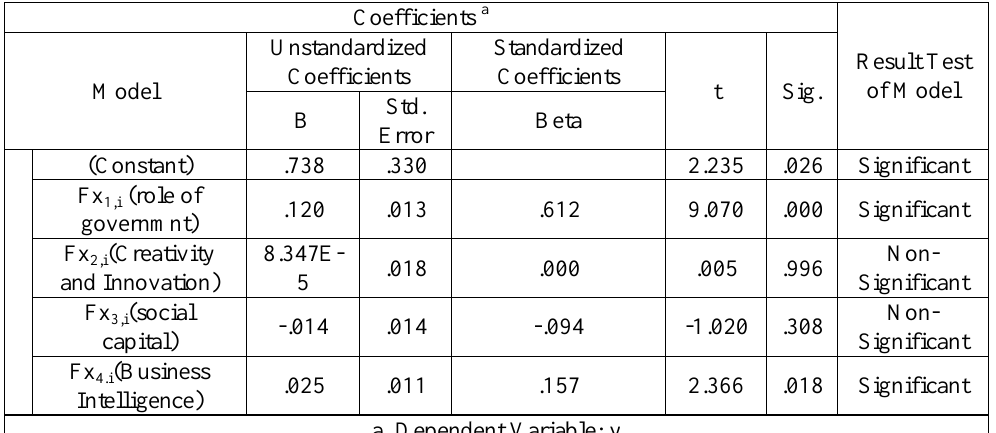
Table. 8. Findings of the Regression Test related to Research Hypotheses